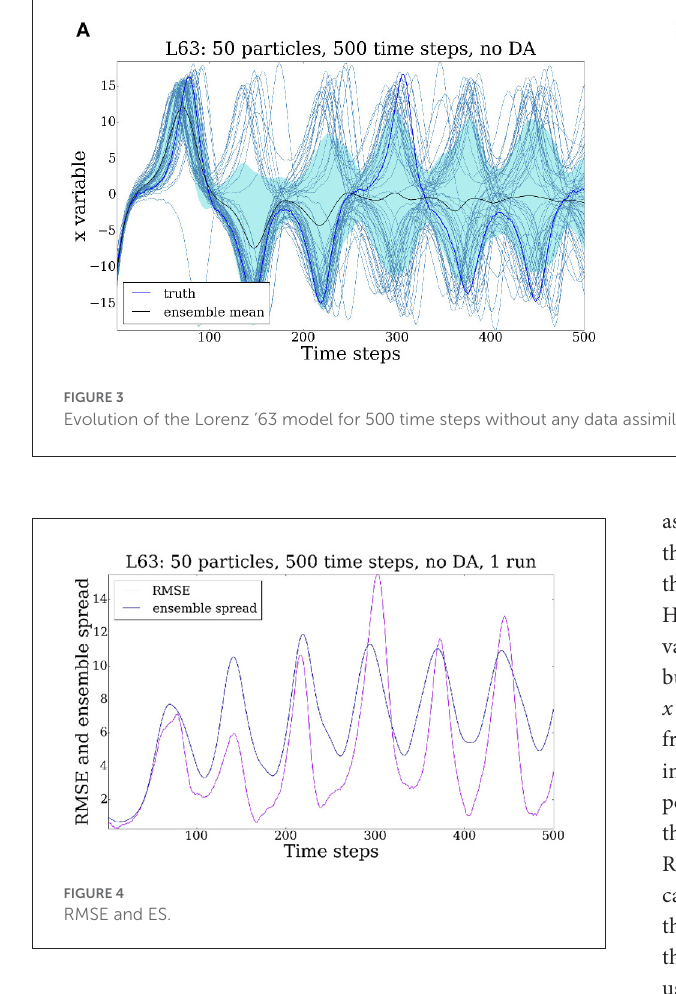
Figure 8D confirm our findings: most of the time, the